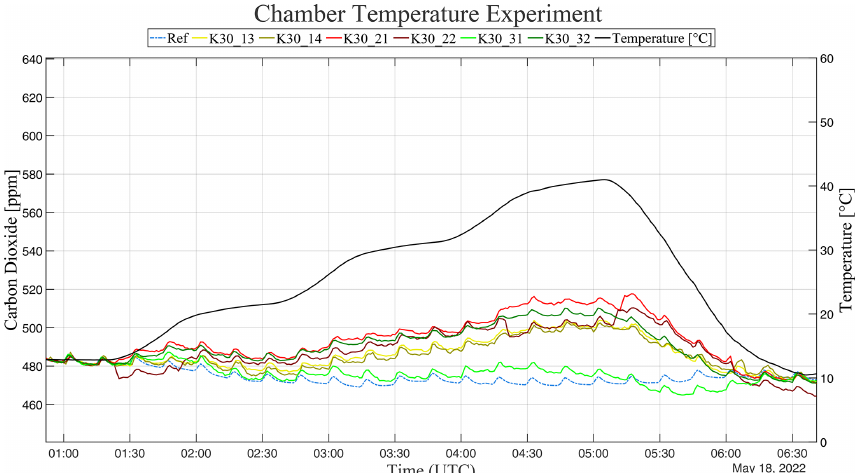
Figure 5. Time-series data for the chambered temperature experiment. The solid black curve represents the temperature inside the chamber. The yellow, green, and red curves represent the CO 2 values reported by the test sensors. The dashed blue curve represents the CO 2 values reported by the reference sensor.